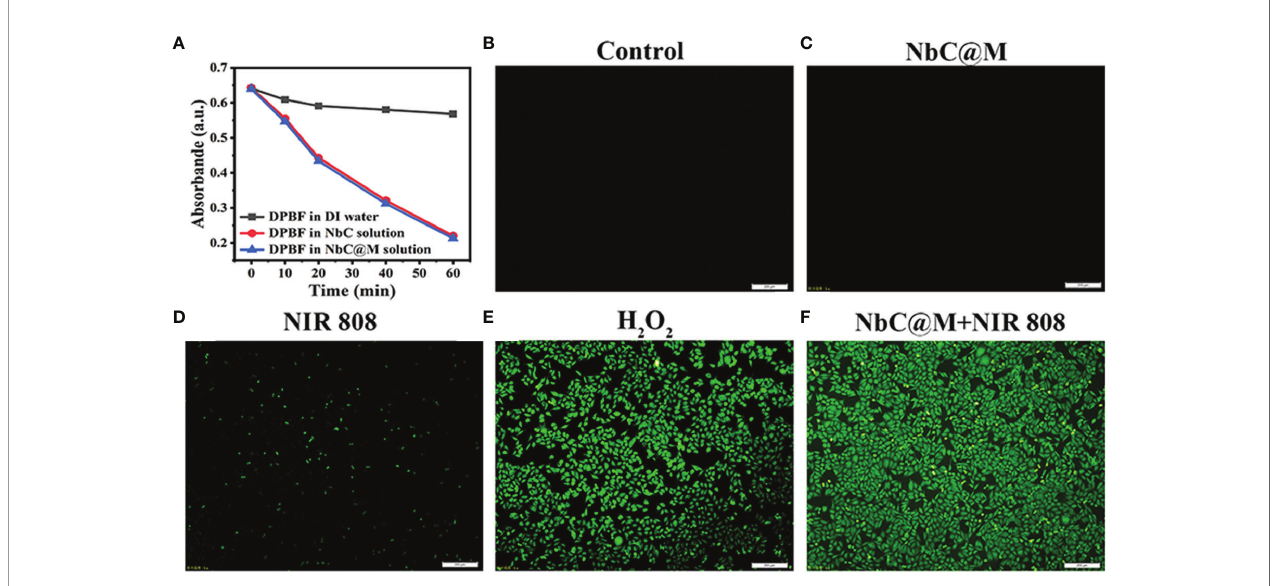
FIGURE 3 | Detection of ROS generation. (A) Degradation curve of DPBF. Fluorescence microscopy images of ROS level for (B) cells without any treatment as a negative control, (C) cells incubated with NbC@M, (D) cells received NIR irradiation, (E) H 2 O 2 treated cells as a positive control, (F) cells treated with NbC@M and NIR irradiation (808 nm, 1W/cm 2 , 10 min; scale bar = 200 m